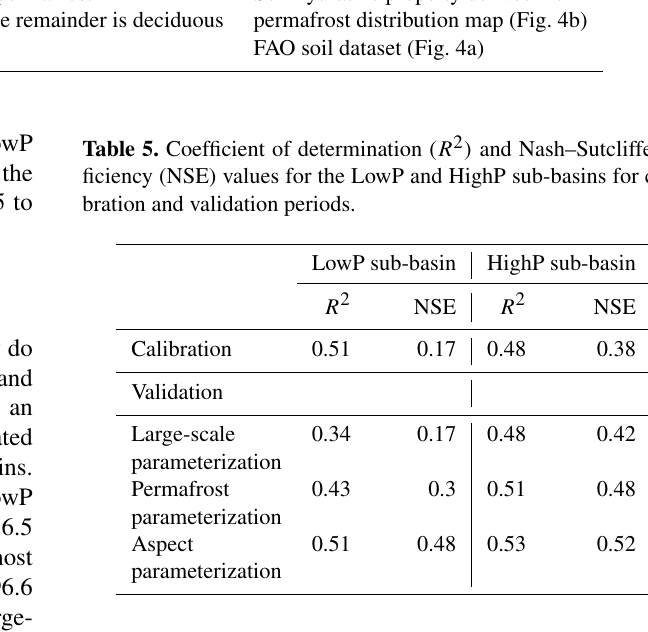
areas are assumed coniferous while the remainder is deciduous